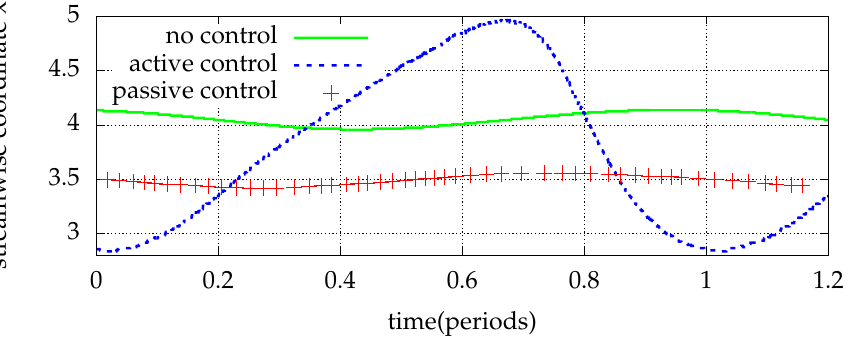
Figure 22. Lower wall reattachment position (LWRP) during a period for the periodic flow over a BFS controlled by an elastic membrane with l = 10, T m = 55, and p e = 0.55. The inflow is defined by Equation (1) with α = 0.05 and ω = 0.05. Comparison with no control and active control